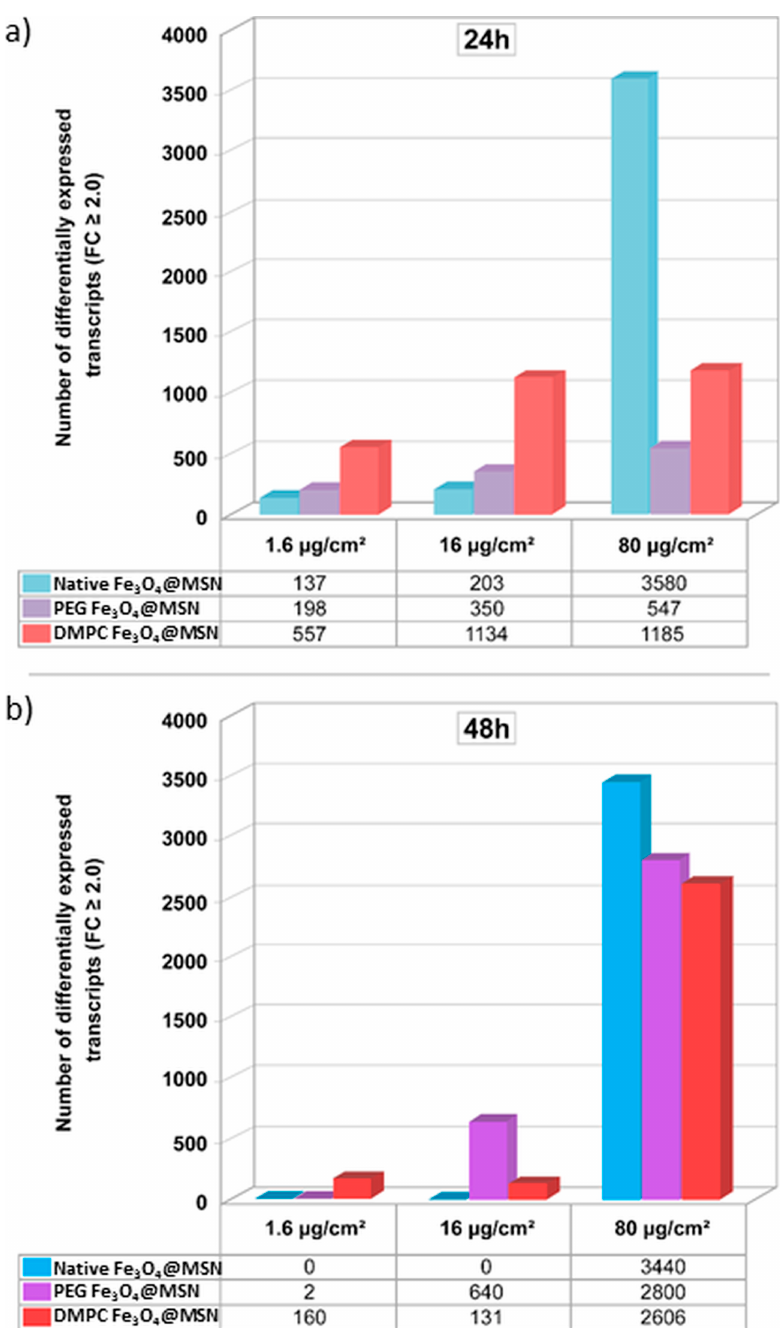
Figure 8. Time- and dose-dependent effects of exposure to Fe 3 O 4 @MSN on the number of significantly differentially expressed genes. HepaRG cells were exposed to 1.6, 16, and 80 μ g cm − 2 pristine, polyethylene glycol (PEG)-, and dimyristoyl phosphatidylcholine (DMPC)-coated Fe 3 O 4 @MSN for 24 ( a ) or 48 ( b ) h. After extraction and labeling, RNA was hybridized to a human oligonucleotide microarray (6 × 60 k Agilent V3 SurePrint). Bars represent the number of differentially expressed transcripts after statistical analysis, using Genespring GX13 software (Agilent), and with a p -value < 0.05 and a fold-change (FC) ≥ 2. Reproduced from Pisani et al. 2017 [6], published under the Creative Commons attribution license CC BY-NC-ND 4.0 by Taylor & Francis publisher.